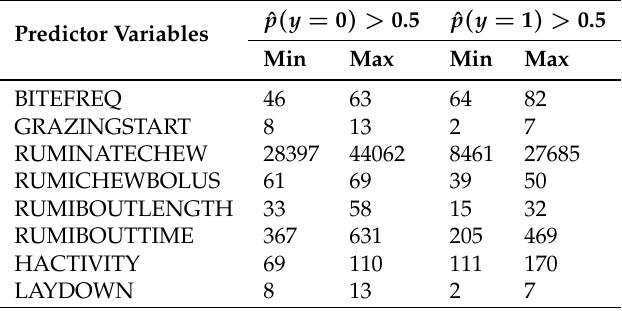
Table 9. Observed ranges of predictor values that correspond to the prediction of sufficient ( y = 0 ) and insufficient ( y = 1 ) herbage allowance by the random forest